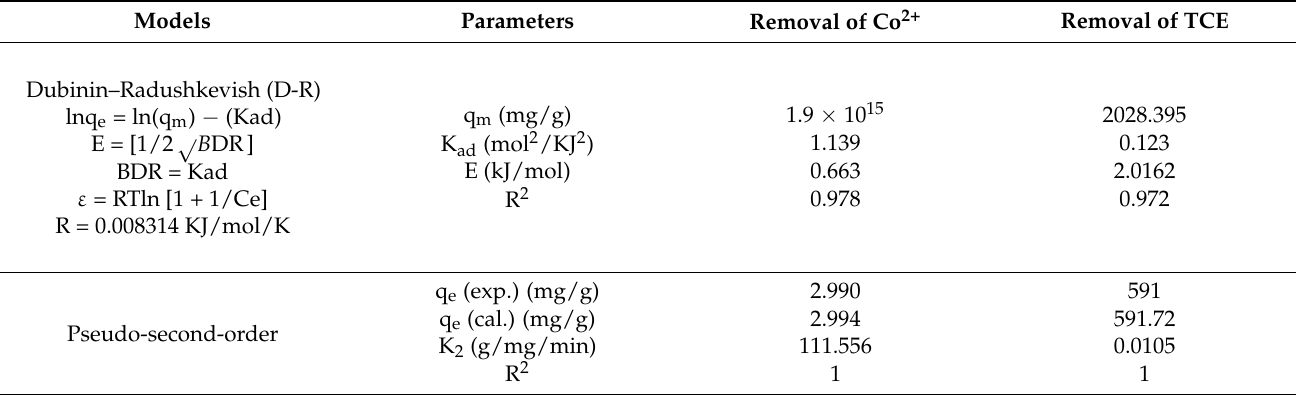
Table 1. Adsorption models and evaluated parameters.